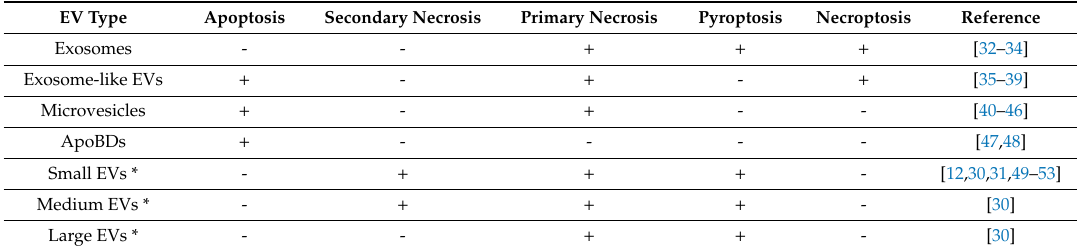
Table 1. Types of EVs released by cells during di ff erent modes of cell death, as reported in literature. EV